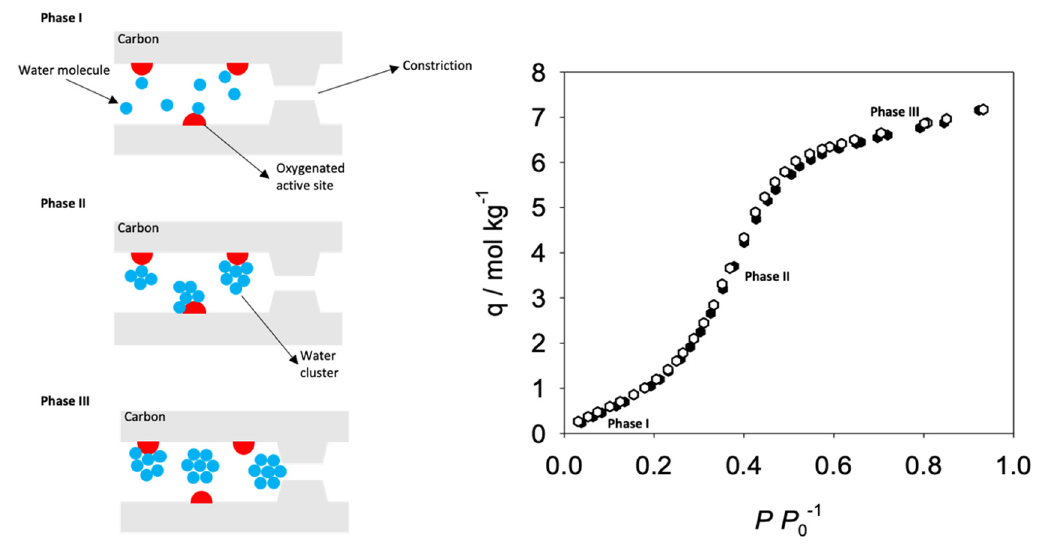
Figure 10. Water vapor adsorption mechanism in CMSM. Water vapor isotherm adsorption of a cellulose-based CMSM (adapted with permission from